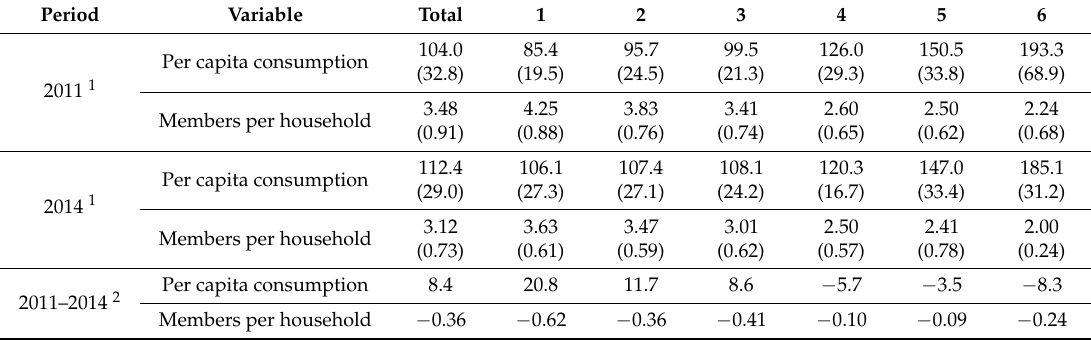
Table 3. Average per capita consumption (L/inhabitant/day) and members per household per unit. Period Variable Total